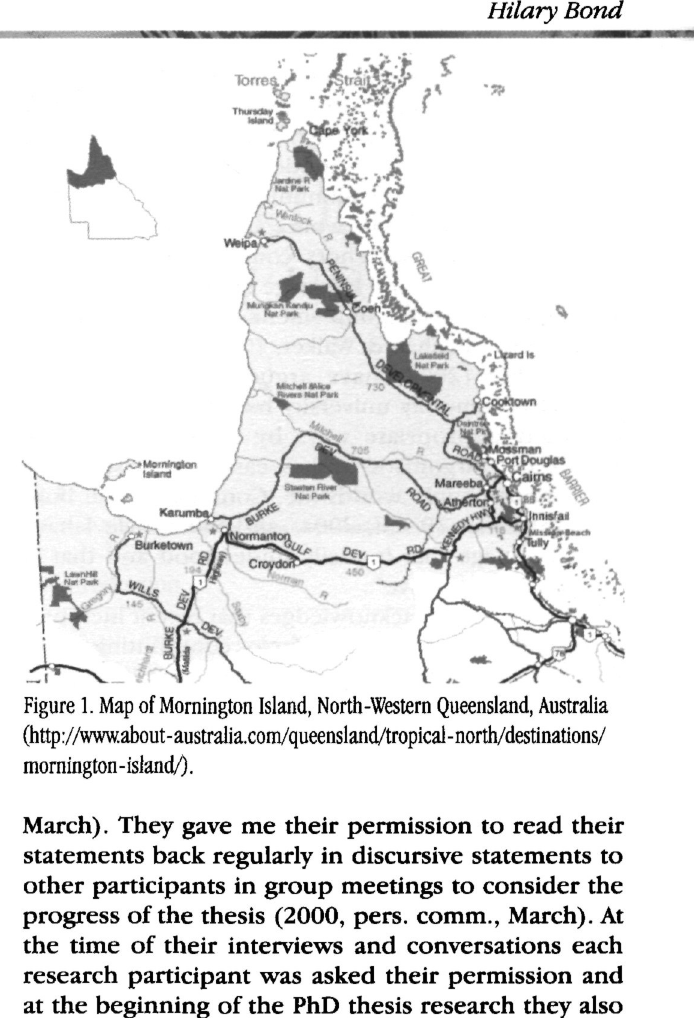
Figure 1. Map of Mornington Island, North-Western Queensland, Australia (http://www.about-australia.com/queensland/tropical-north/destinations/